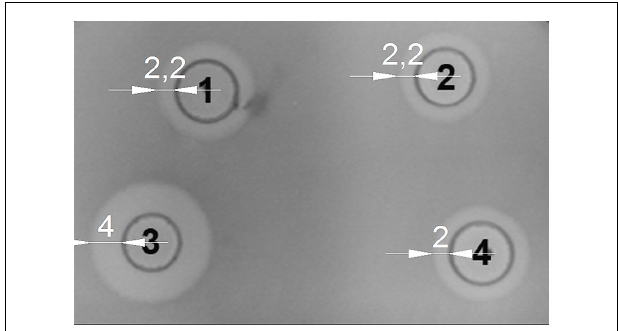
FIGURE 6 | LcnB activity of BGMN1-501 and its PrtP – mutant before and after incubation with PrtP proteinase extract of BGMN1-501/pG + host9lcnB (LcnB – mutant). (1) LcnB of BGMN1-501 with NaPi; (2) LcnB of BGMN1-501 with PrtP of BGMN1-501/pG + host9lcnB; (3) LcnB of PrtP − mutant with NaPi; (4) LcnB of BGMN1-501/pG + host9prtP with PrtP proteinase of BGMN1-501/pG + host9lcnB. Note that the zone of growth inhibition is rendered to that of the original